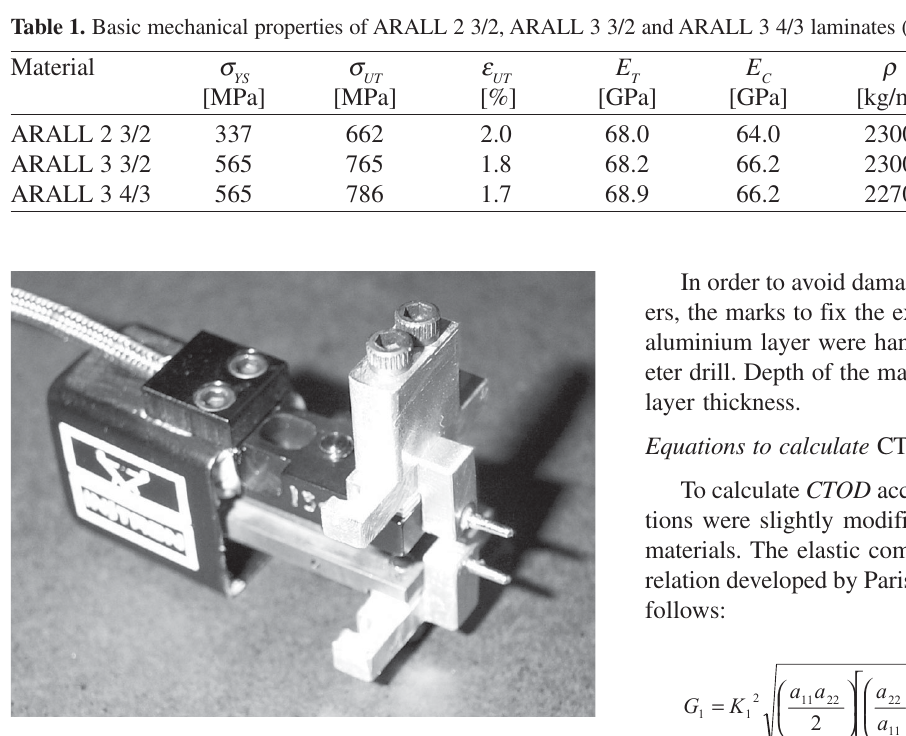
Figure 3. Modified commercial extensometer (INSTRON) for δ measurement.